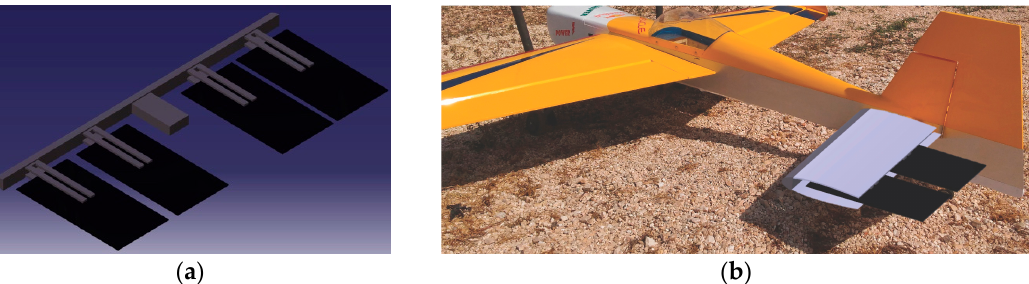
Figure 18. New horizontal tail concept: ( a ) bistable horizontal tail in CATIA and ( b ) UAV equipped with the concept of a horizontal bistable stabilizer.